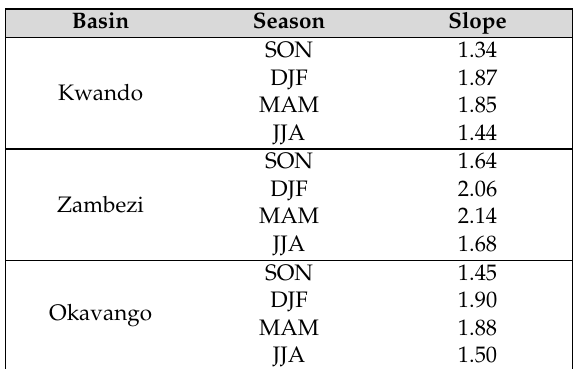
Table 2. Comparison of regression slopes for the cumulative NDVI by basin and season. Slope represents the cumulative increase in NDVI each year.